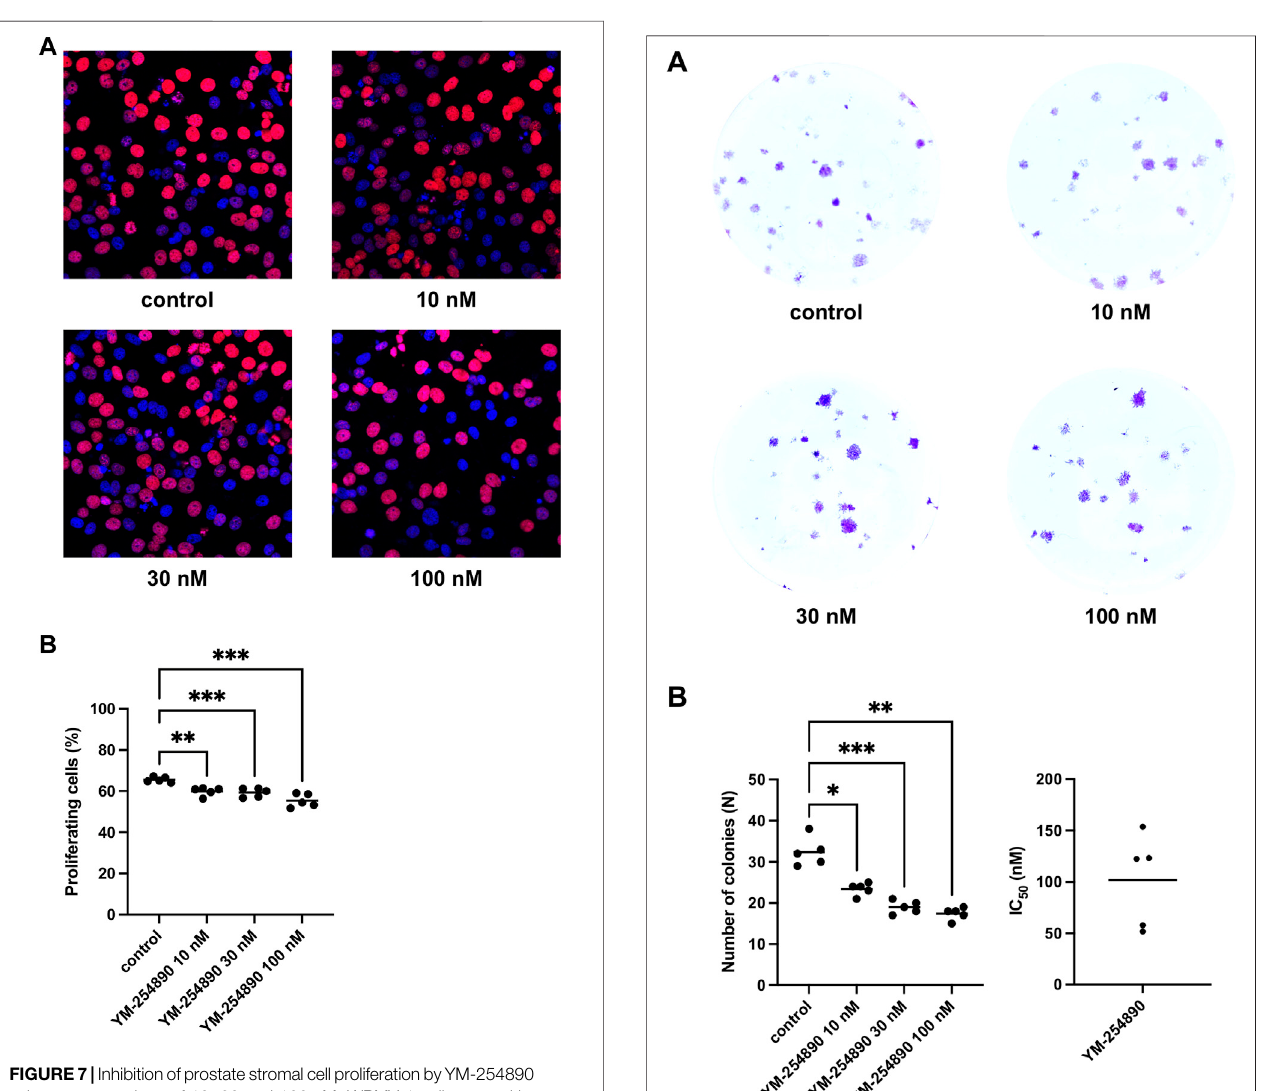
FIGURE7| InhibitionofprostatestromalcellproliferationbyYM-254890 using concentrations of 10, 30 and 100 nM. WPMY-1 cells were either allocatedtoaYM-254890group,orcontrolgroupcontainingequalamountof solvent (DMSO, 10 μ l/ml), and incubated for 72 h. Shown are the percentages of proliferation (means) as scatter plots containing data of each individual experiment, which were assessed by EdU assay for each concentration, using cell cultures from n = 5 independent experiments for each concentration (** p < 0.01, *** p < 0.001). Proliferating cellswere detected by EdU staining and counterstaining of all nuclei with DAPI, followed by fl uorescence microscopy, resulting in blue-colored nuclei for non-proliferating cells and red nuclei for proliferating cells. Shown are exemplary images of cell proliferation (A) , and quanti fi cation of all experiments (B) .